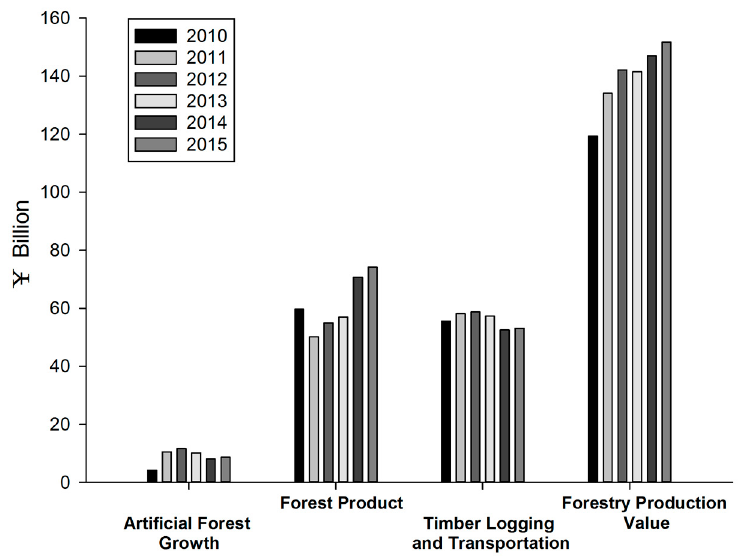
Figure 11. Forestry production value change in Zhejiang Province from 2010–2015.